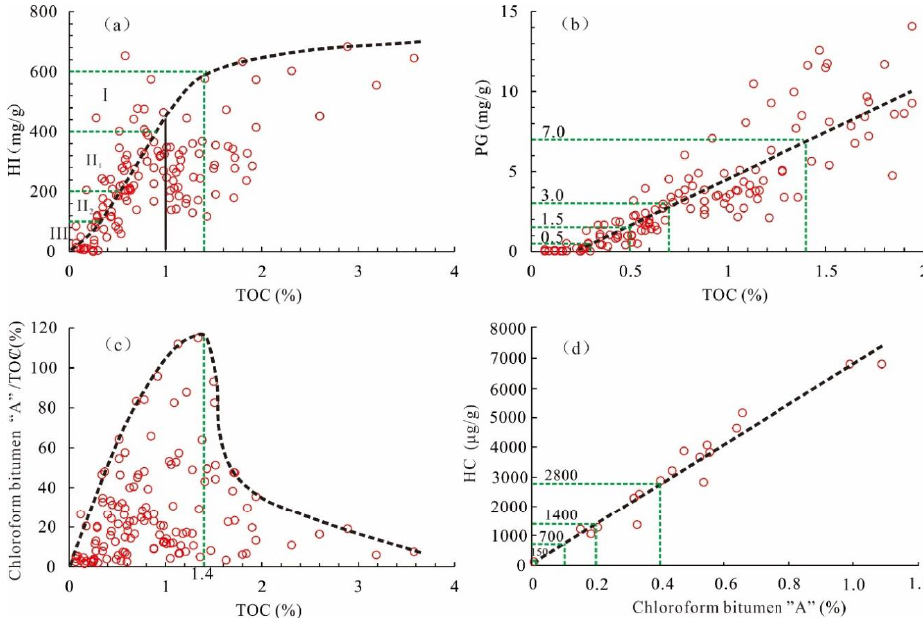
Figure 8. Limit chart of source rock evaluation indexes of the Fengcheng Formation in the Mahu Sag. ( a ) Plot of TOC versus HI. ( b ) Plot of TOC versus PG. ( c ) Plot of TOC versus chloroform bitumen “A”. ( d ) Plot of chloroform bitumen “A” versus HC. Table 2. Evaluation standard of continental alkaline lake source rock.